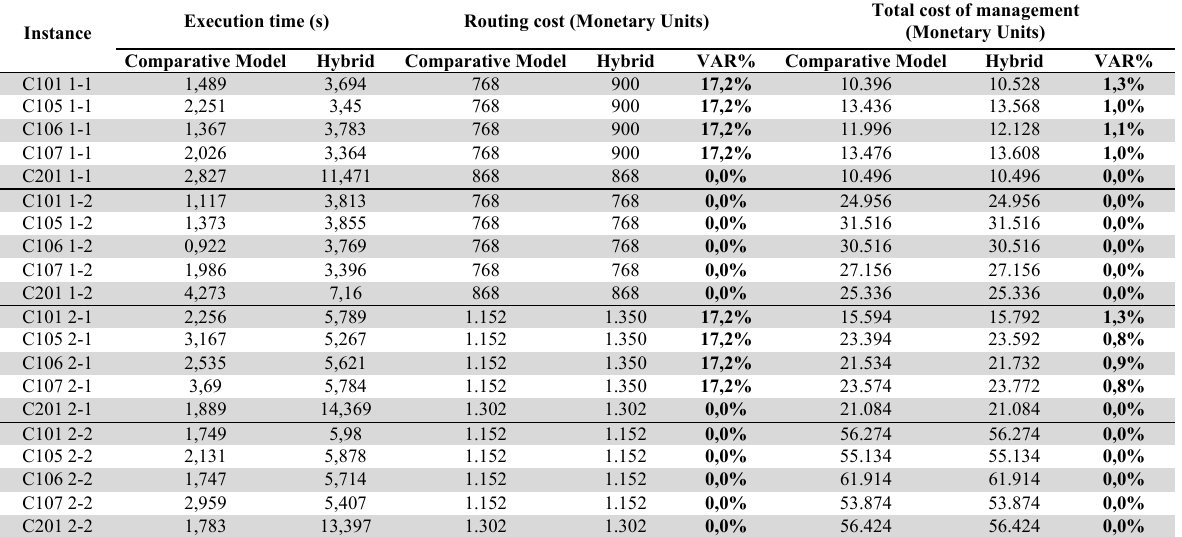
Table 5 Performance comparison for groups of 25